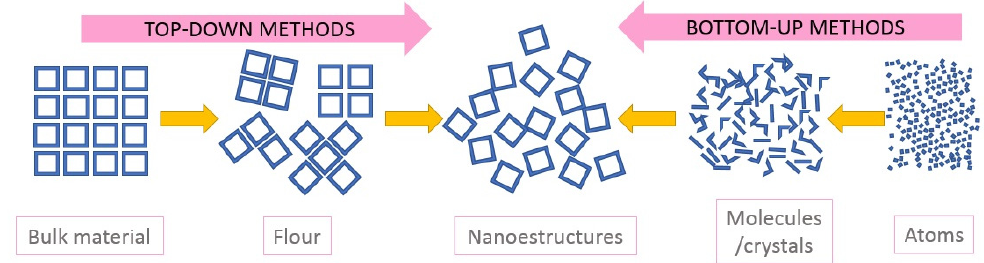
Figure 1. Synthesis methods of nanoparticles and nanostructures.